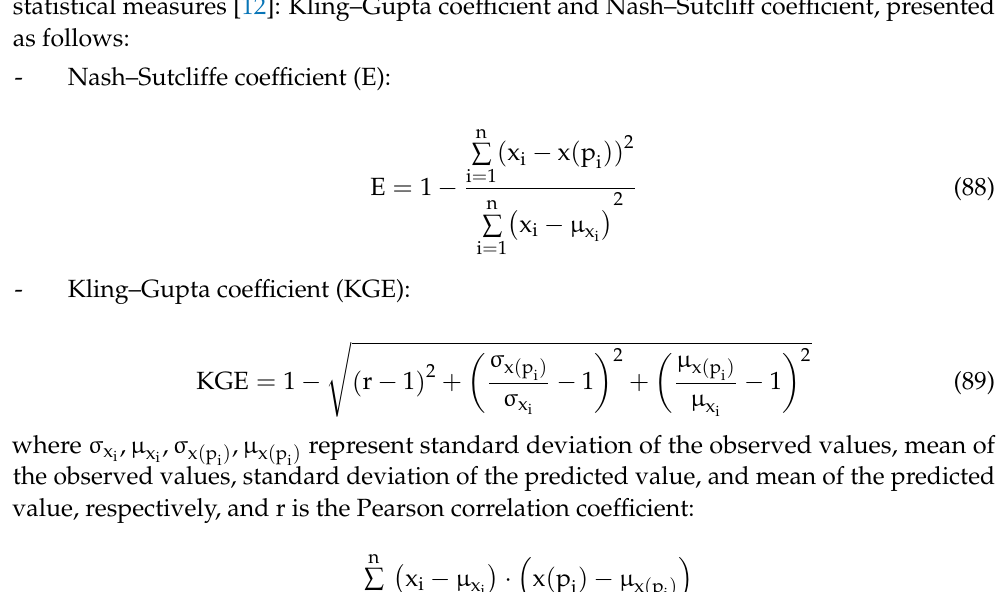
Figure 7. Comparison of estimation with ( a ) MOM, ( b ) L-moments, and ( c ) LSM.